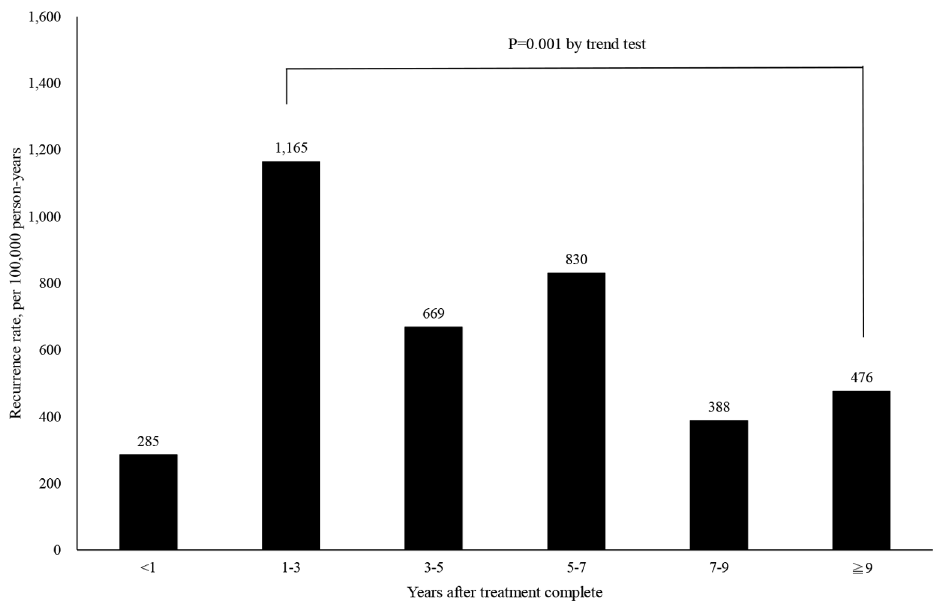
Fig 2. Incidence of recurrent tuberculosis among 4041 patients being treated for Mycobacterium tuberculosis infections. The incidence peaked within 1 to 3 years after treatment complement and gradually declined from trend